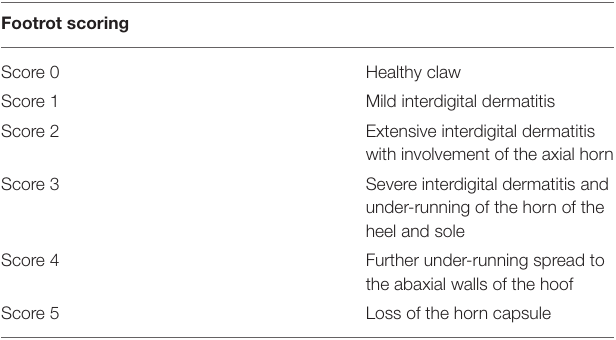
TABLE 1 | Footrot scoring system according to BGK a ; adapted from Egerton and Roberts (43). Footrot